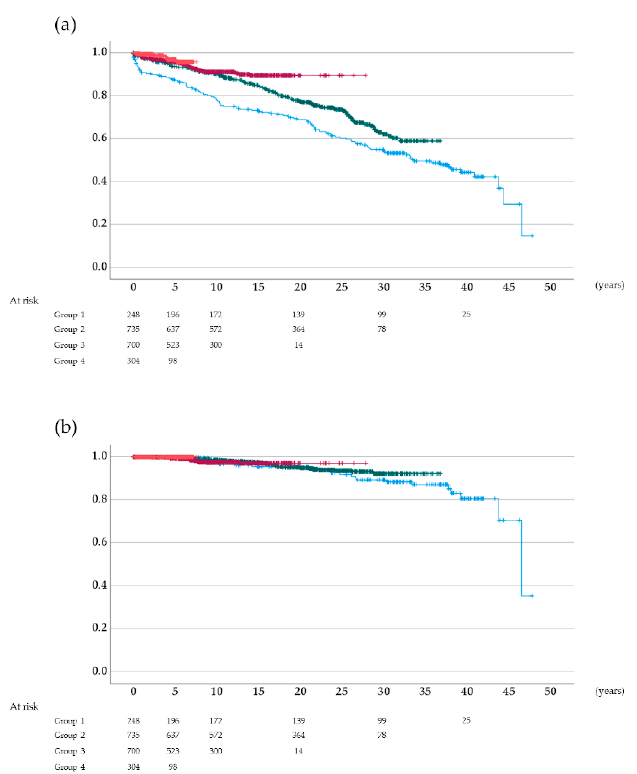
Figure 3. ( a ) Overall and ( b ) cancer-specific survival rates after kidney transplantation: Blue, group 1; green, group 2; dark red, group 3; vermilion, group